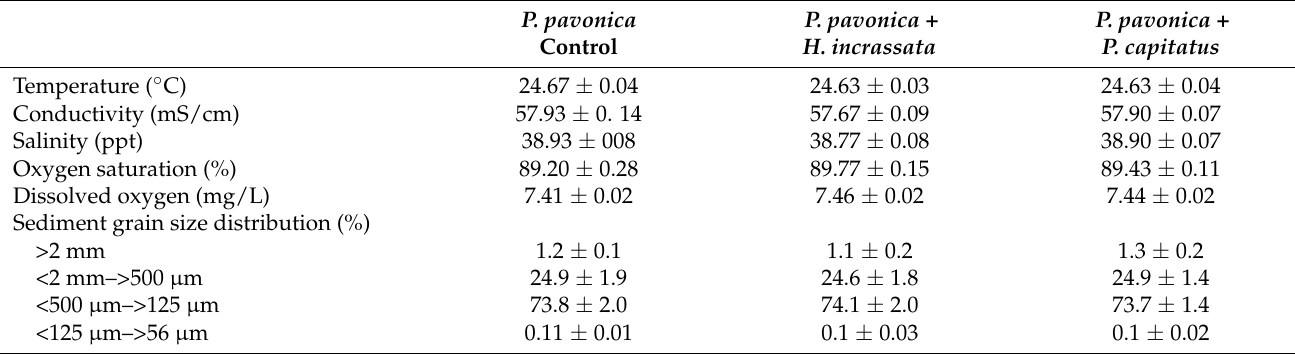
Table 1. General characteristics of the three sampling